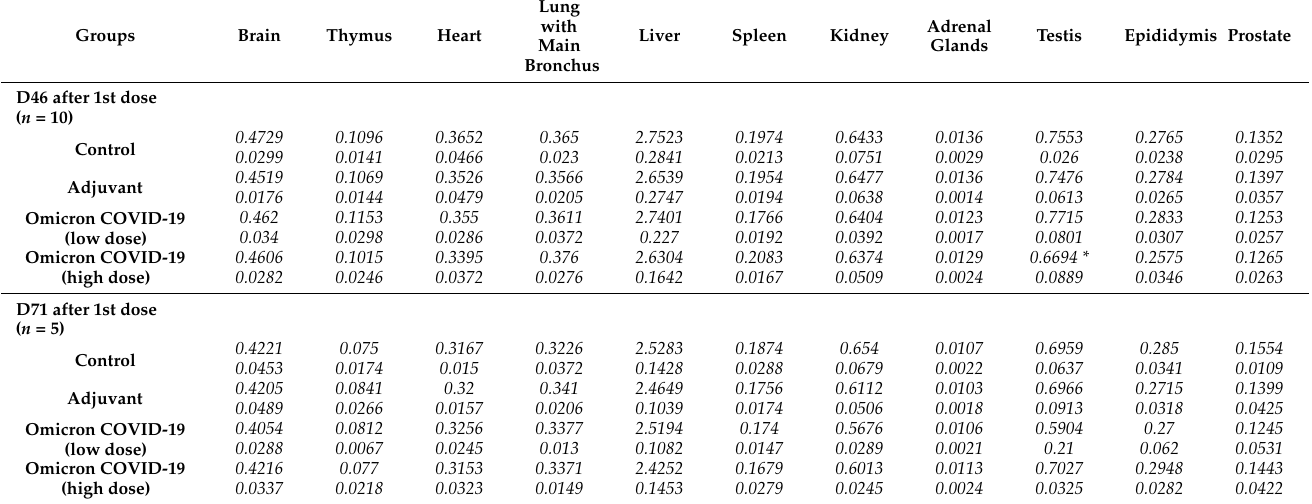
Legend: Values represent the mean of the 10 (D46) or 5 (D71) animals in each group per time-point. Relative organ weight is the ratio of organ weight and animal weight on the day of euthanasia. Italic values represent the standard variation (SD) per group. * = p ≤ 0.05